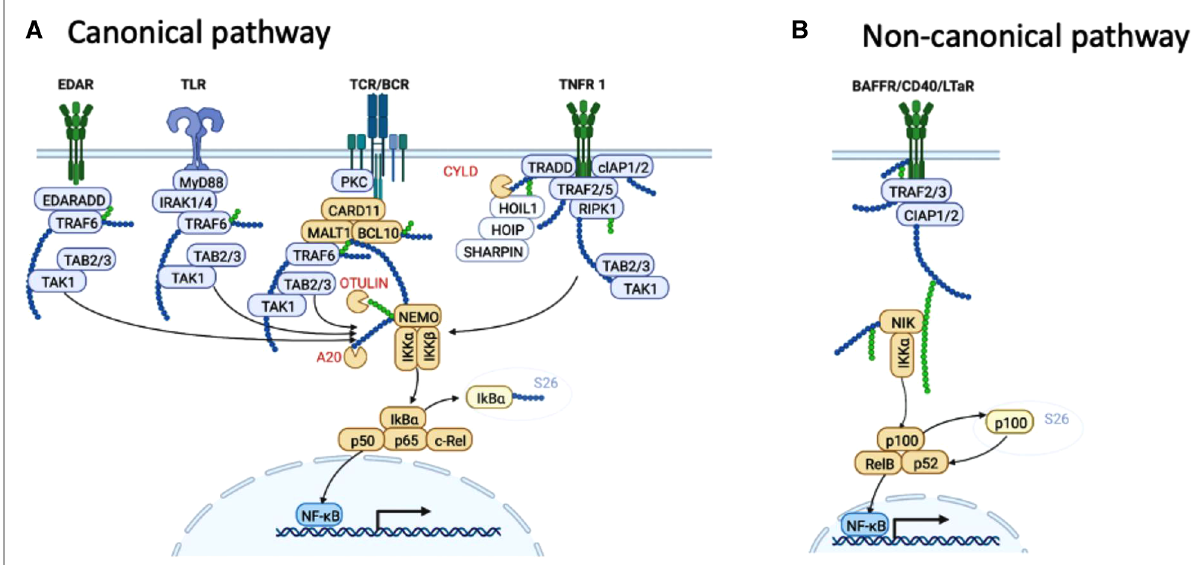
FIGURE 1 NF- κ B pathways. ( A ) Summary of ligands and signalling events that lead to activation of the canonical (classical) NF- κ B pathway. ( B ) Summary of ligands and signalling events that lead to activation of the non-canonical (alternative) NF- κ B pathway. Proteins discussed in this review are shown in orange. Created with